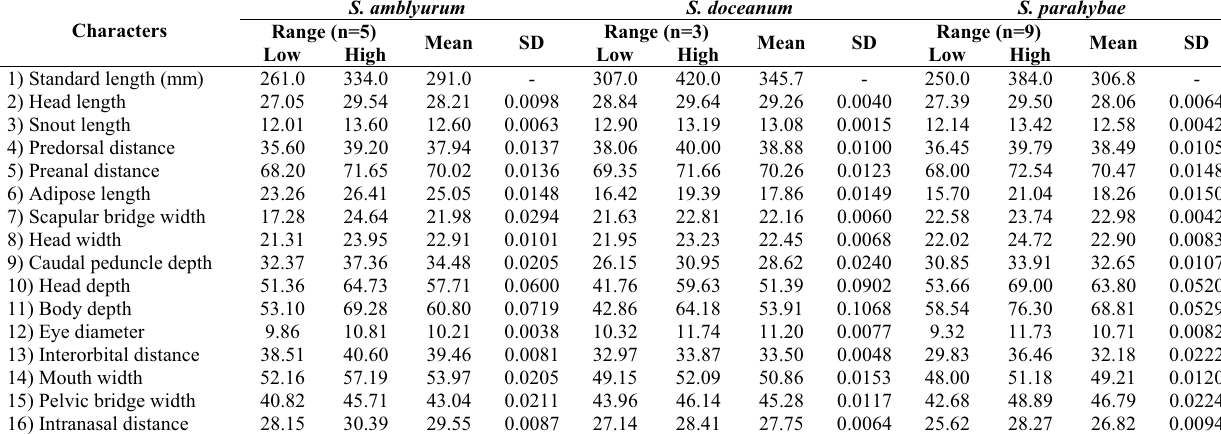
Table 1. Morphometrics of S. amblyurum , S. doceanum and S. parahybae expressed as percent of SL (2-8) and HL